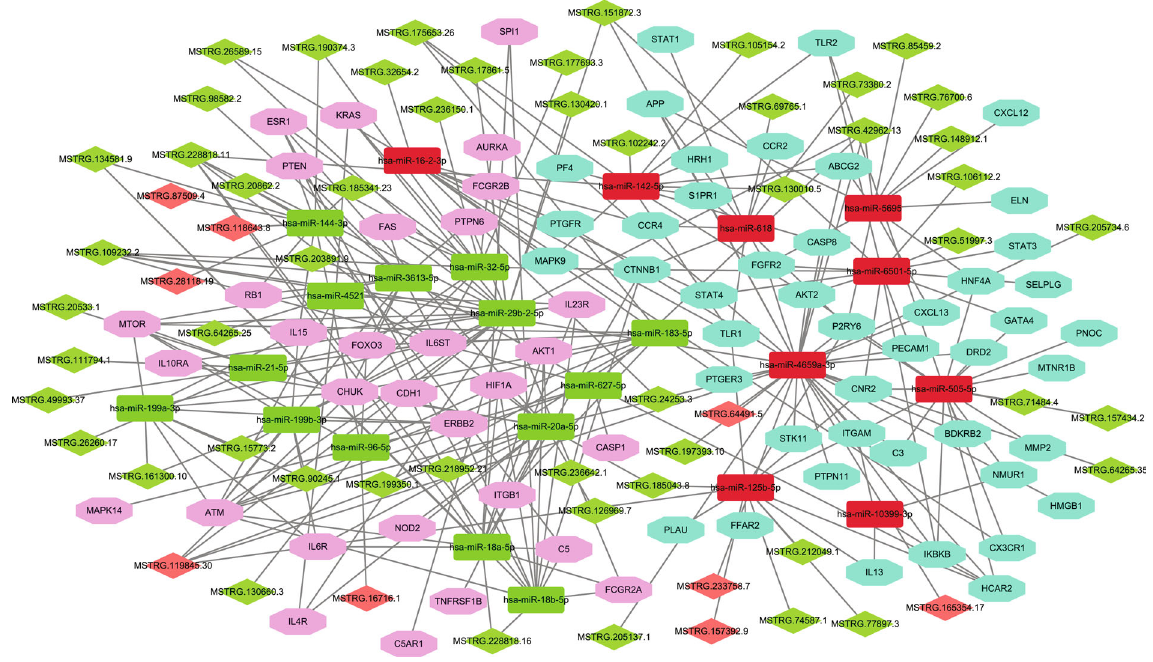
Figure 8: The competing endogenous RNA (ceRNA) network of COVID-19. Pink octagon indicates the upregulated DE mRNAs, light blue octagon indicates the downregulated DE mRNAs, red rectangle indicates upregulated DE miRNAs, green rectangle indicates downregulated DE miRNAs, red diamond indicates upregulated DE lncRNAs, and green diamond indicates downregulated DE